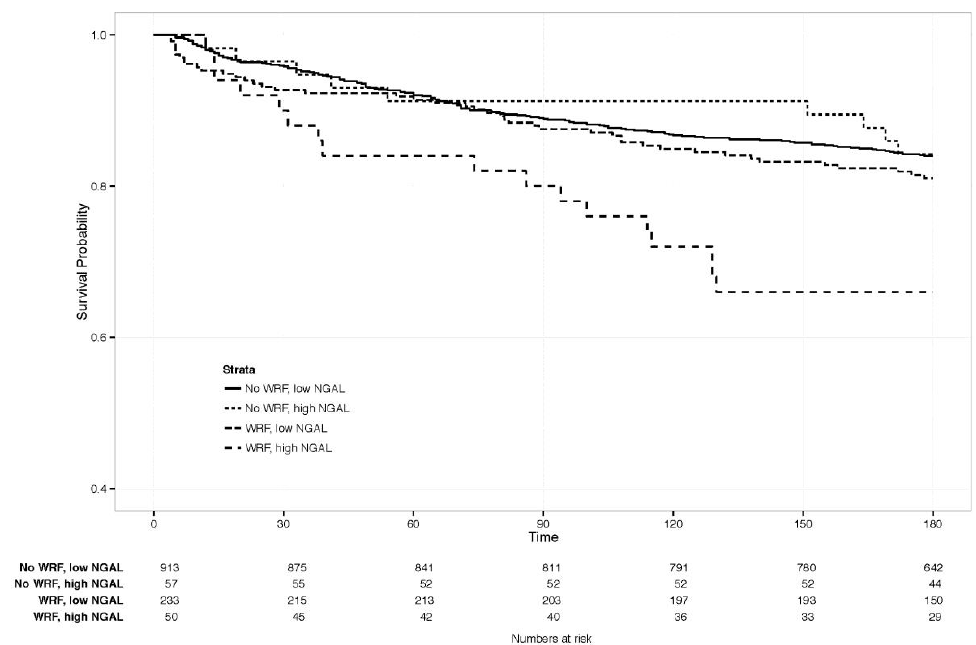
Figure 4. 180-day survival in patients with vs. without WRF, high vs. low NGAL change. Creat: creatinine. NGAL: Neutrophil Gelatinase-Associated Lipocalin. High vs. low, defined as an NGAL increase of ≥1 standard deviation (≥88 ng/mL increase).